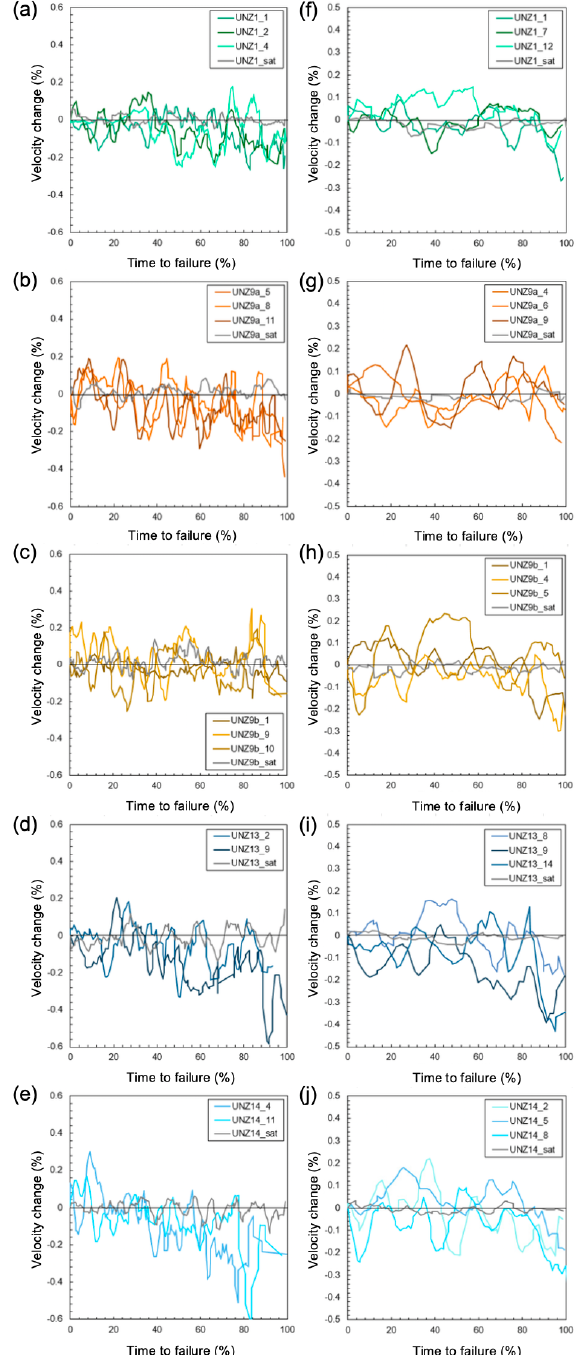
Figure 8. Coda wave interferometry data presented as velocity change as a function of time to failure (normalised to test length) for dry and saturated (sat) conditions: UCS tests on samples (a) UNZ1, (b) UNZ9a, (c) UNZ9b, (d) UNZ13, and (d) UNZ14; and UTS tests on samples (f) UNZ1, (g) UNZ9a, (h) UNZ9b, (i) UNZ13, and (j) UNZ14. For UCS tests (a–e) , velocity reduces after ∼ 50% time to failure for dry tests but continues to fluctuate about zero (no velocity change) throughout saturated tests. For UTS tests (f–j) , ve- locity reduces after 60%–70% time to failure for dry tests and also continues to fluctuate about zero for the saturated